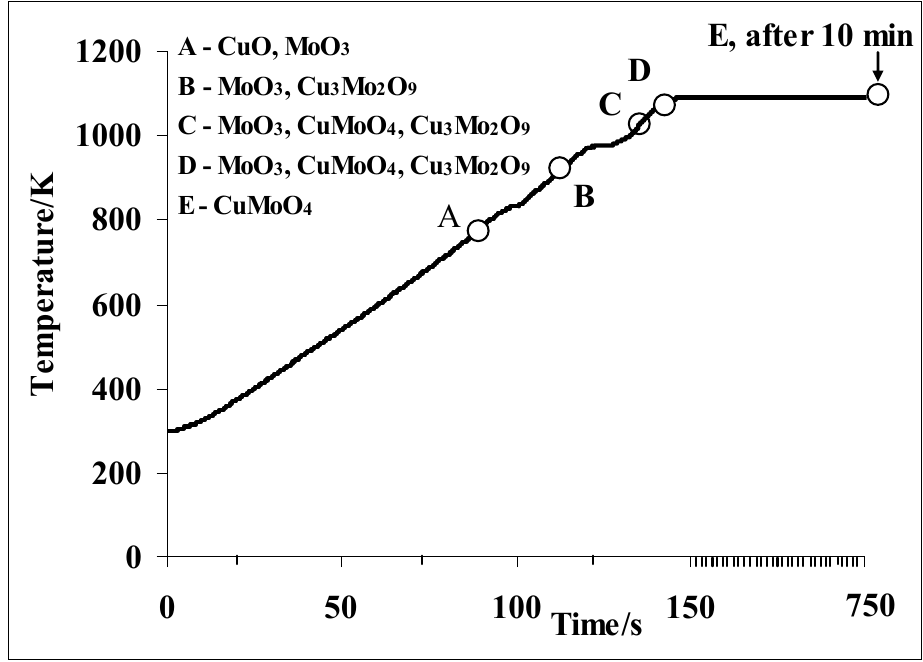
Figure 2. The heating thermogram of the CuO + MoO 3 mixture with the XRD analysis results of the quenched samples at different characteristic temperatures, A—T = 773, B—923, C—1023, D—1073, E—1073 (t h = 10 min) K, V h = 300 K min − 1 .